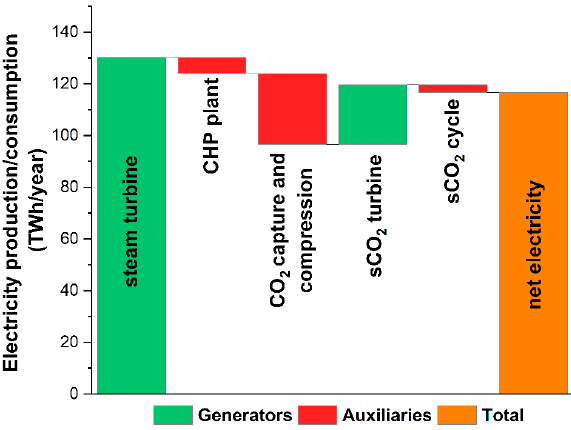
Figure 8. Annual electricity balance of the analyzed system.